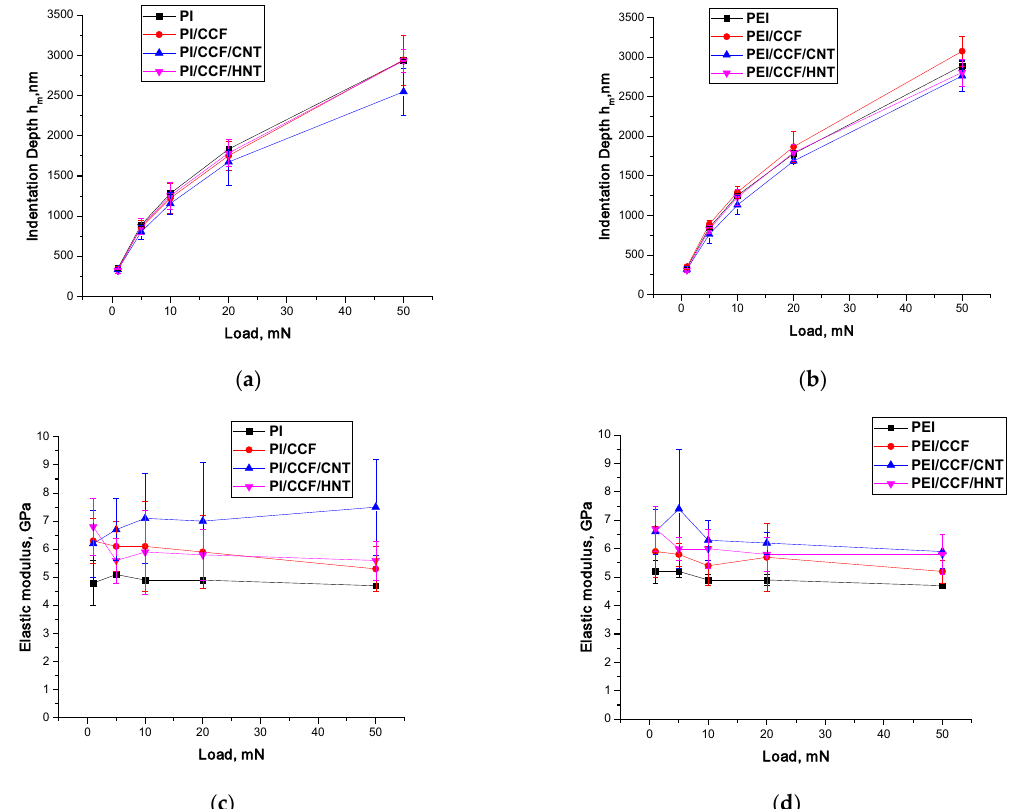
Figure 12. The nanoindentation data for the wear tracks on both neat PI and PEI, as well as on their nanocomposites. Linear tribological contact. P = 60 N, V = 0.3 m/s. Indentation depth ( a , b ) and Elastic modulus ( c , d ).